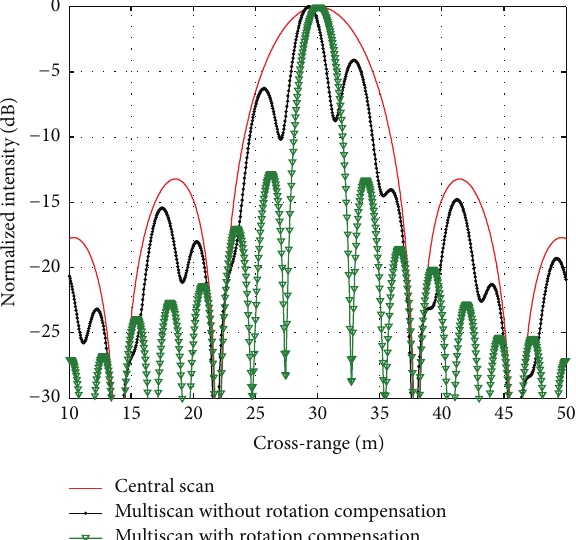
Figure 6: ISAR profiles for successive integrated scans.